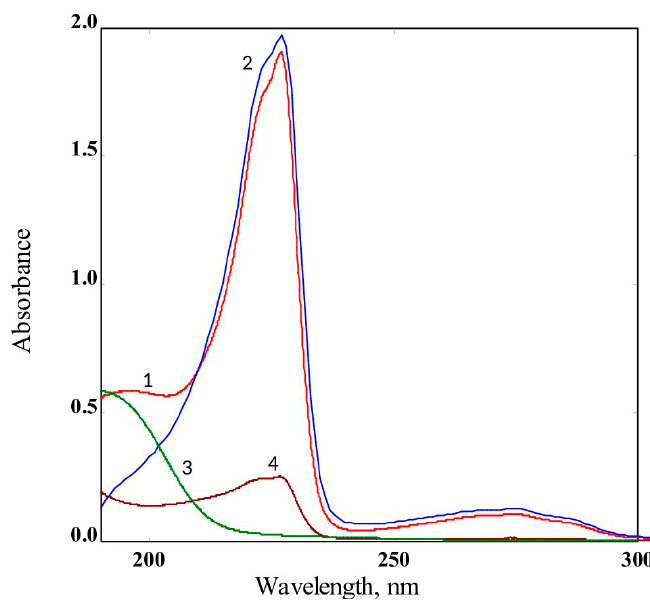
Figure 8. UV-visible spectra of: PHMG-NS (1); sodium 2-naphthalene sulfonate (2); PHMG hydrochloride (3) (C = 4.5 × 10 − 5 mol / L), and water solution after seven-day contact with PA-11/PHMG-NS (7%) film (4).